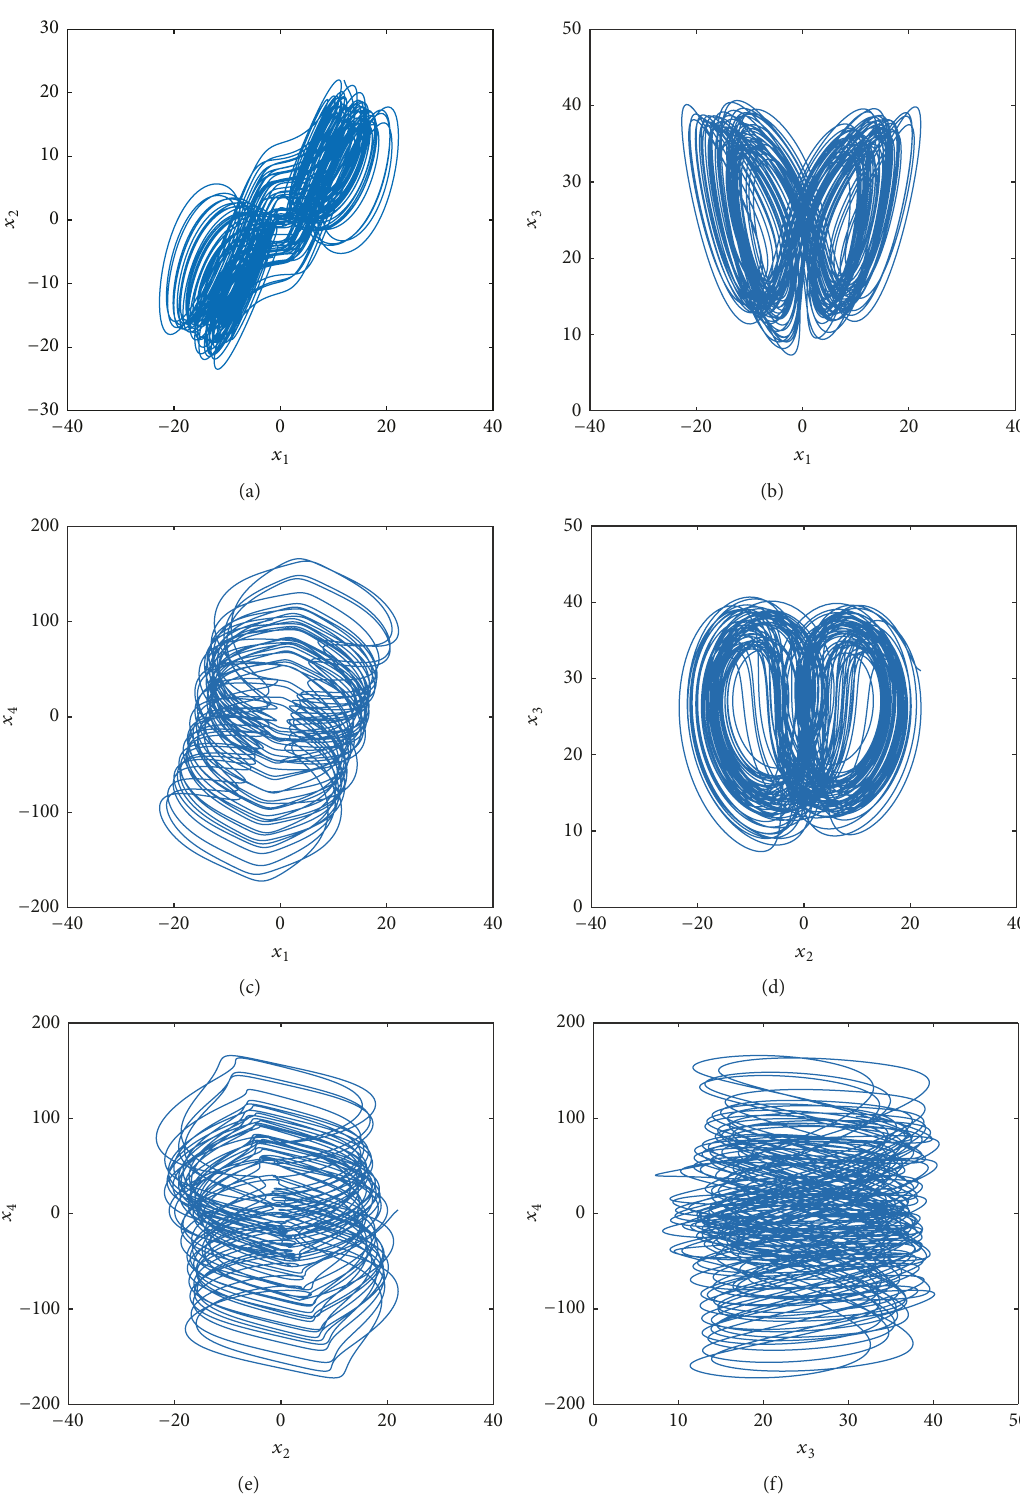
Figure 1: Phase diagrams of the fractional-order Lorenz hyperchaotic attractor. (a) 𝑥 1 - 𝑥 2 plane, (b) 𝑥 1 - 𝑥 3 plane, (c) 𝑥 1 - 𝑥 4 plane, (d) 𝑥 2 - 𝑥 3 plane, (e) 𝑥 2 - 𝑥 4 plane, and (f) 𝑥 3 - 𝑥 4